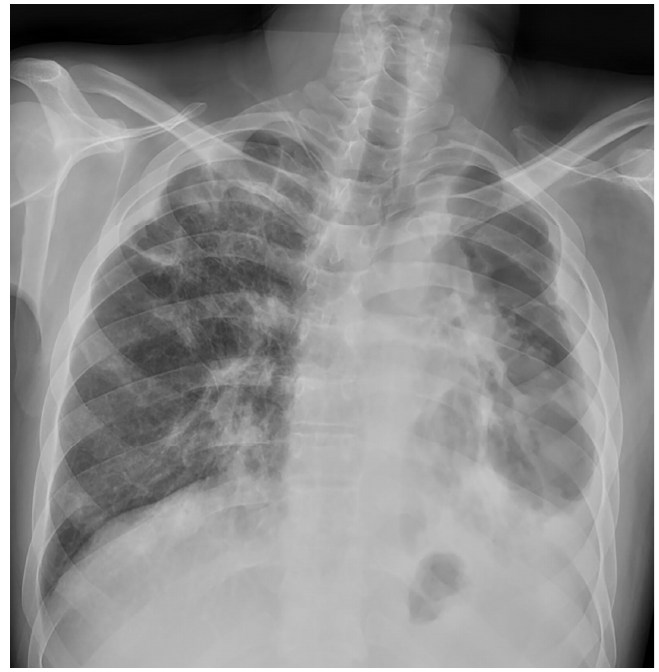
Figure 2. Case 4, 59th day of the treatment.